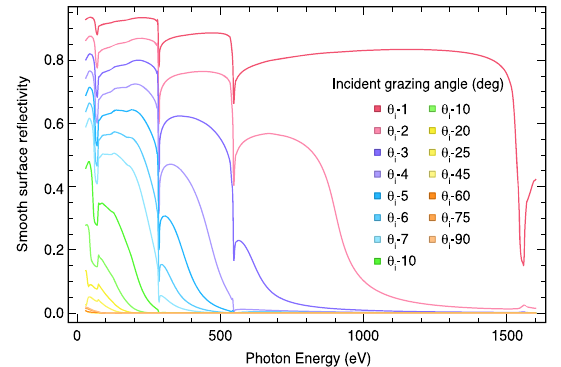
FIG. 2. Specular reflection probability [16], vs photon energy and angle, for an rms surface roughness of 100 nm. The curves have been computed from Eq.